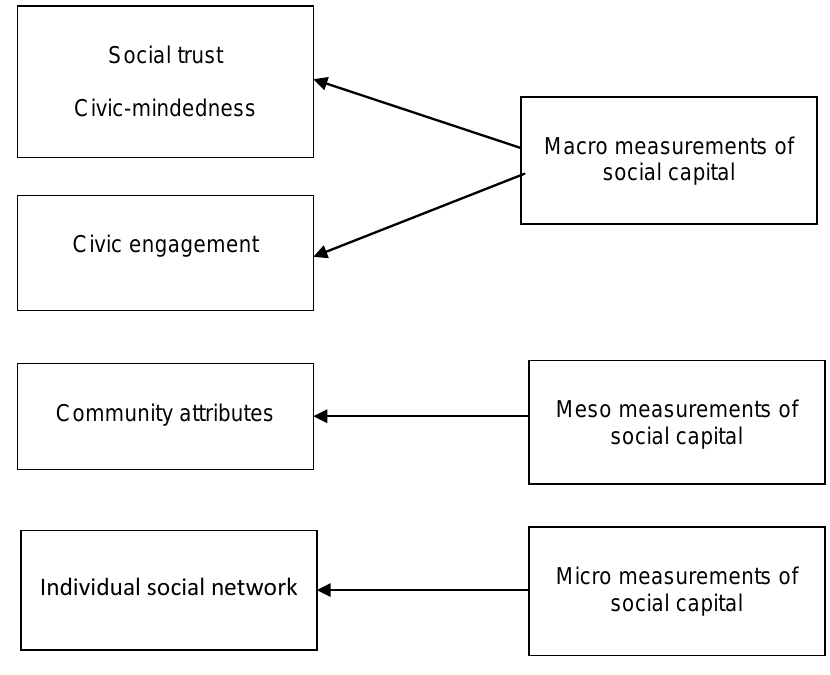
Figure 3 . Micro, meso and macro measurements of social